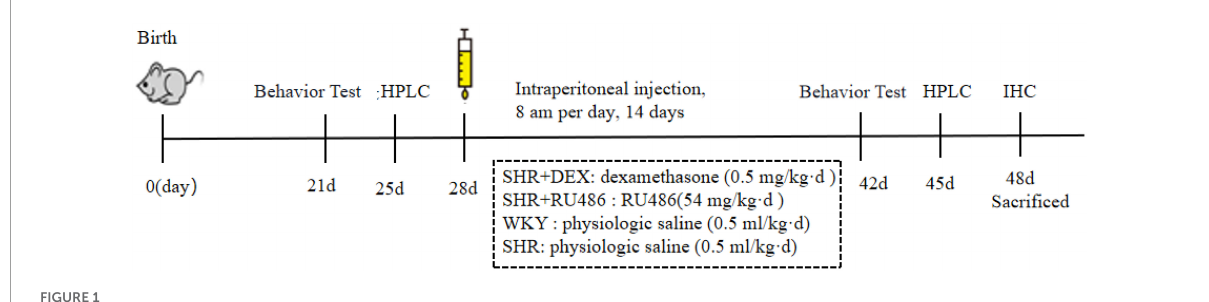
FIGURE1 Schematic of experimental